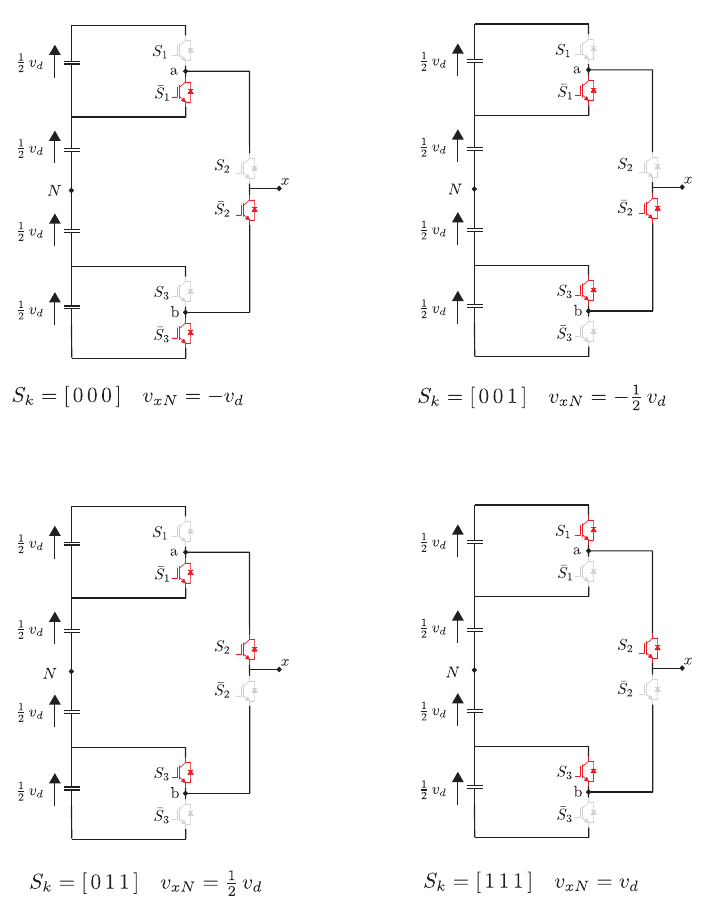
Figure 3. LS-PWM (level-shifted pulse-width modulation) scheme switching states. In the LS-PWM scheme all the carrier signals are level shifted and in-phase with each other. The required number of carriers N c for a n level converter is obtained by